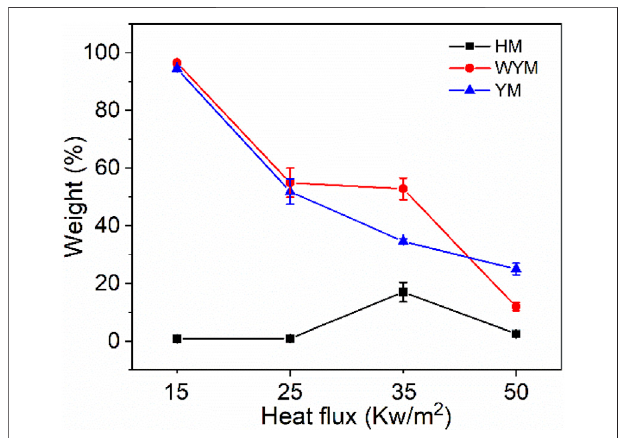
FIGURE 16 | Variation trend of coal residual char